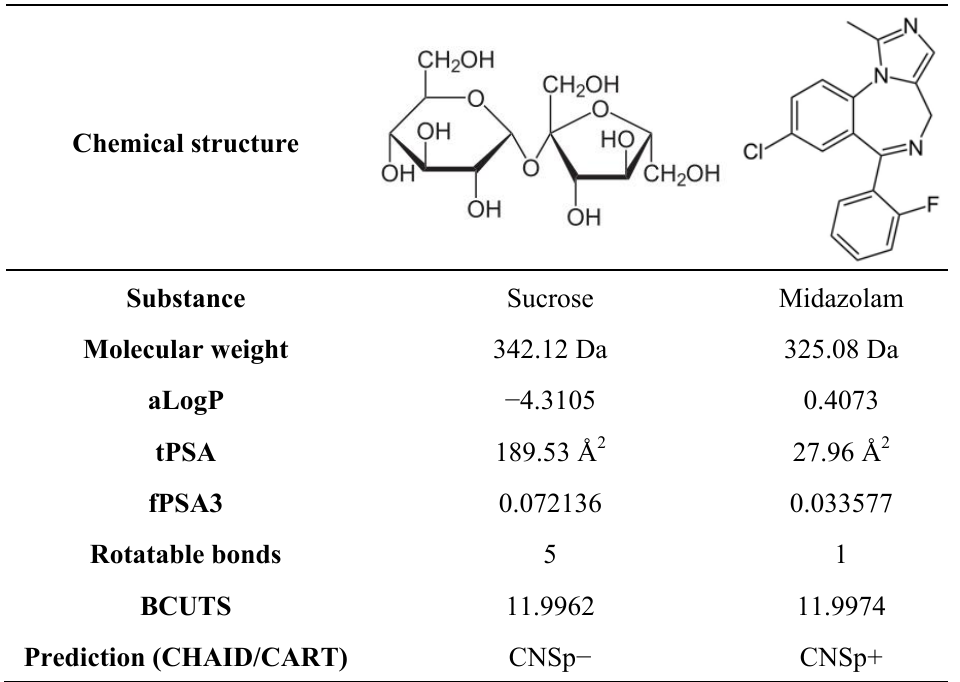
Table 3. Example of the implementation of decision tree models. Calculated physico- chemical descriptors are used for the prediction of strong (CNSp+) or weak (CNSp − ) blood-brain barrier permeation of two test